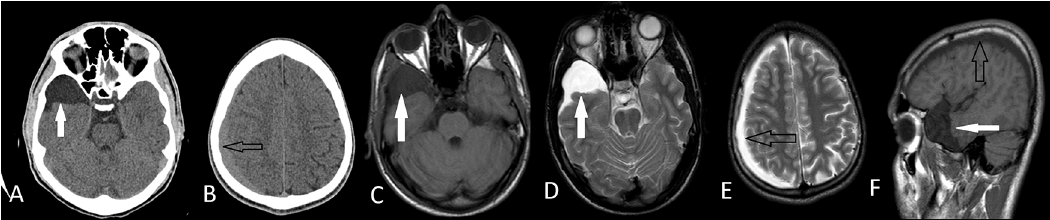
Figure 2. Axial CT images of right middle fossa arachnoid cyst (A) (white arrows) and ipsilateral subdural hematoma (B)(blackarrows)oftheCase3. AxialT1WMRI(C),T2WMRI (D,E)andsagittalMRI(F)imagesshowsthat they are apart from each other. He had conservative treatment with a complete